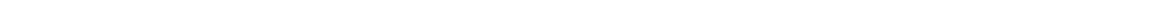
Fig. 3 Overcoming drug resistance by targeted production of reactive oxygen species in mitochondria. a When irradiated with NIR laser, the LSC nanoparticles can speci fi cally produce reactive oxygen species (ROS) in mitochondria. This oxidizes NADH into NAD + to inhibit the production of ATP, which stops the function of the ef fl ux pumps and overcomes the cancer drug resistance. b Representative TEM images of NCI/RES-ADR multidrug- resistant cells incubated in medium without (Control) or with LSC-D nanoparticles. M indicates the mitochondria. Arrows indicate the LSC-D nanoparticles in mitochondria. E/L indicates endosome/lysosome. Scale bar: 2 and 0.3 μ m for low and high magni fi cation images, respectively. c Confocal images of NCI/RES-ADR cells treated with LSC and LSC-D nanoparticles showing the speci fi c production of ROS in mitochondria. Scale bar: 10 μ m. d Quantitative data on ROS production in NCI/RES-ADR cells under various conditions. Error bars represent s.d. ( n = 3). The LSC + L group is compared with the LSC group with the same LSC concentration, as well as the control (medium) and laser (alone) groups. * p < 0.05 (Kruskal – Wallis H -test). e Relative NADH in NCI/RES-ADR cells showing the decrease of NADH in cells treated with LSC nanoparticles with laser irradiation (LSC + L, 1 W cm − 2 for 1 min). Error bars represent s.d. ( n = 3). The LSC + L group is compared with the LSC group with the same LSC concentration, as well as the control (medium) and laser (alone) groups. * p < 0.05 (Kruskal – Wallis H -test). f Consumption of ATP by the membrane proteins isolated from NCI/RES-ADR cells showing the transmembrane ef fl ux pumps are not bound with ATP in the cells treated with LSC + L so that signi fi cantly more ATP can be consumed/bound by them. Error bars represent s.d. ( n = 3). The LSC + L group is compared with the LSC group with the same LSC concentration, as well as the control (medium) and laser (alone) groups. * p < 0.05 (Kruskal – Wallis H